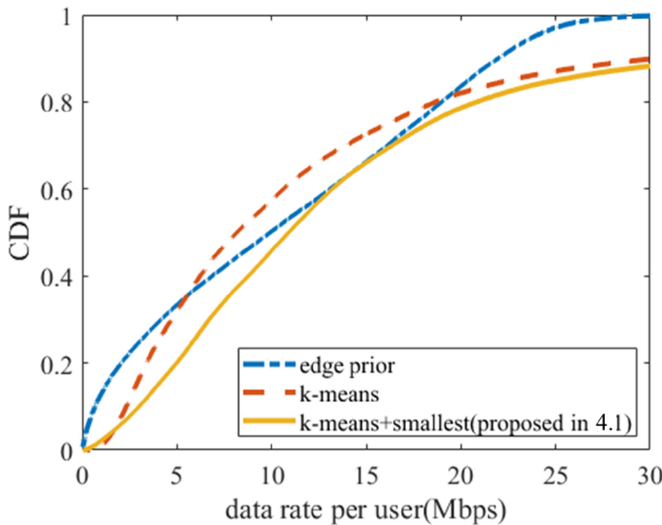
Figure 7. CDF of the data rate for each UAV deployment method.